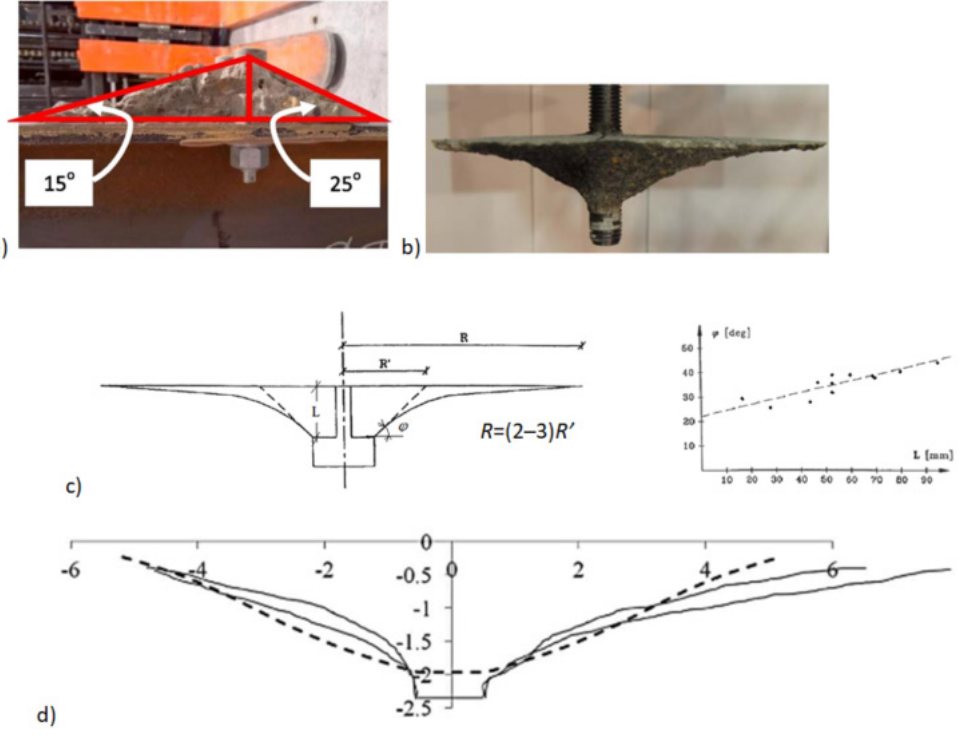
Figure 4: Real extent of the loosening process based on literature data: a, b) concrete cone [12, 23]; c) radius R observed by test and effective radius R’ used in model [3]; d) comparison between LEFM predictions (dashed lines) and experimental crack propagation patterns [19]. LEFM, linear elastic fracture mechanics.